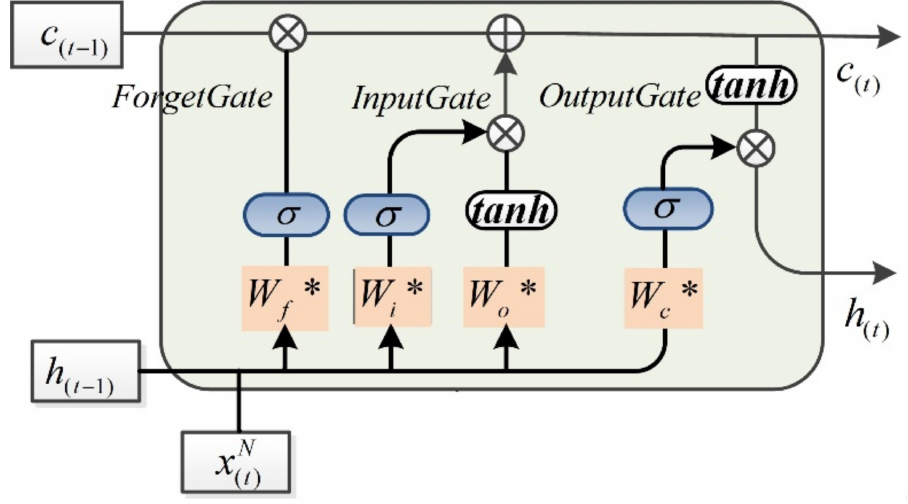
Figure 5. ConvLSTM